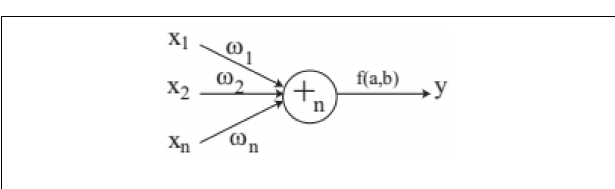
FIGURE 2 | A flexible neuron